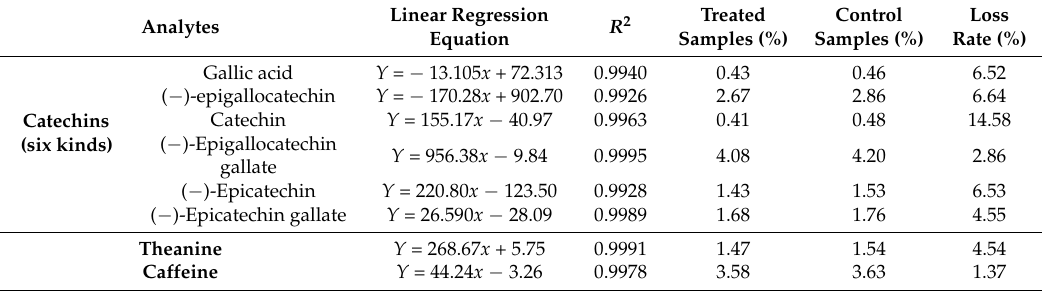
Table 3. Catechins, theanine and caffeine contents in tea leaves treated by subcritical butane